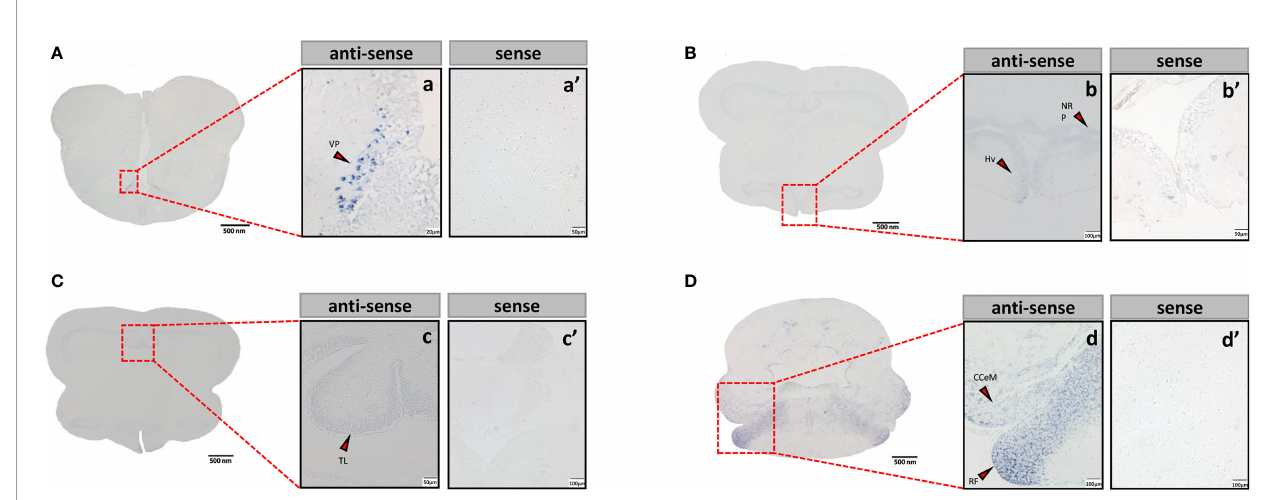
FIGURE 5 | Tac3a mRNA in the brain of Japanese eel was detected by in situ hybridization (ISH). Tac3a localization in the telencephalon (A) , thalamus (B) , midbrain (C) , and cerebellum (D) . Scale bar = 500 m m. Positive signal of tac3a in the telencephalon (a) , thalamus (b) , midbrain (c) , and cerebellum (d) . Negative signals of tac3a with sense probe results in the telencephalon (a ’ ) , thalamus (b ’ ) , midbrain (c ’ ) , and cerebellum (d ’ ) . b, c ’ , d, d ’ : Scale bar = 100 m m. a ’ , b ’ , c: scale bar = 50 m m. a: scale bar = 20 m m. VP, the postcommissural nucleus of the ventral telencephalon; Hv, the ventral hypothalamus; NRP, the nucleus of the posterior recess; TL, the torus longitudinalis; RF, the reticular formation; CCeM, the molecular layer of corpus